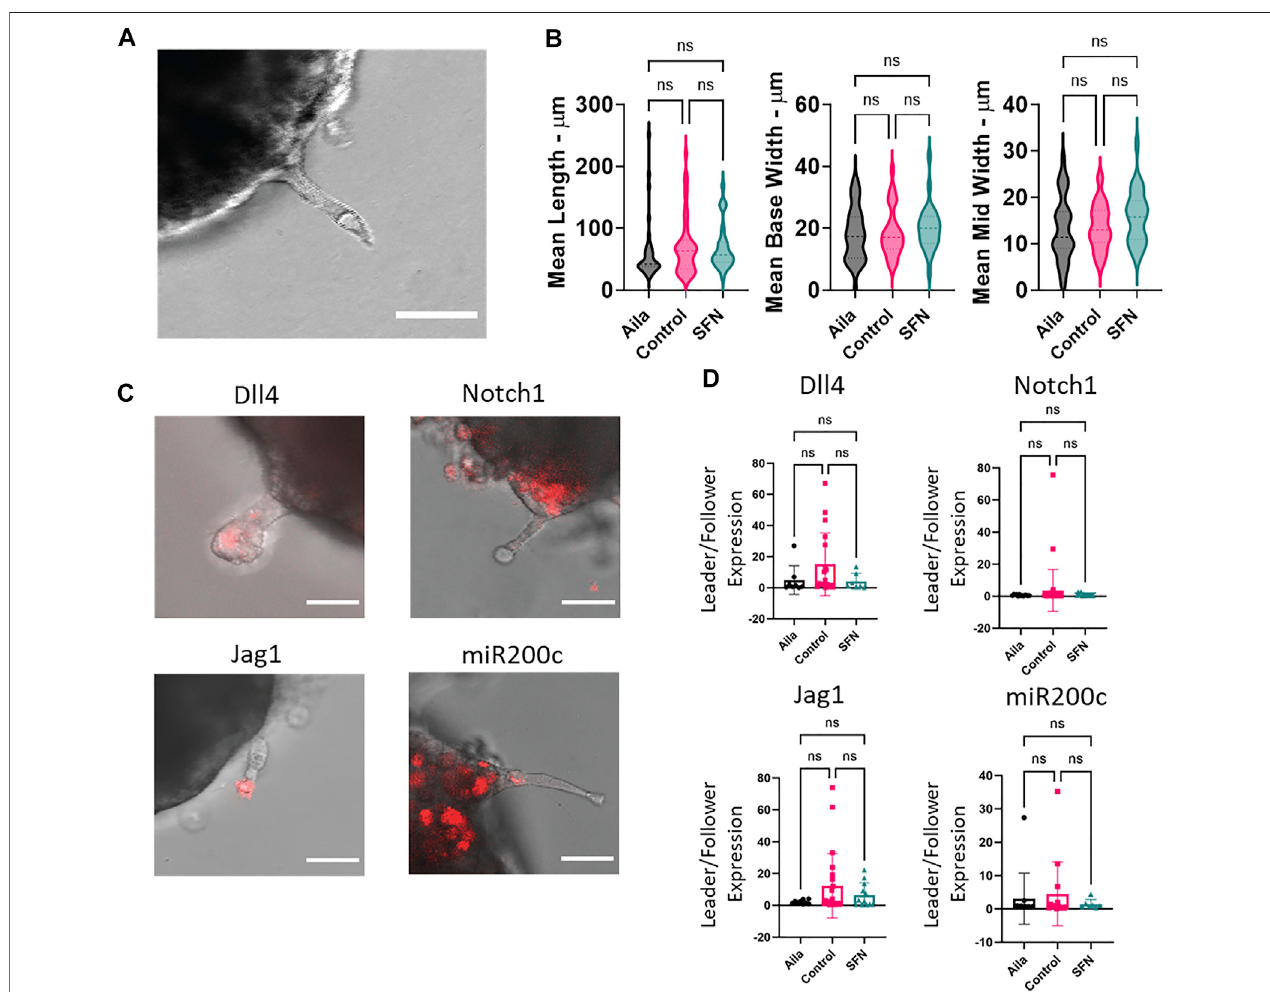
FIGURE9| Theeffects ofAilanthoneand sulforaphaneonleader and follower cells. (A) Representativeimage ofasproutprotrudingfrom a3Dmicrotumor formed byHeLacells. (B) Unlikethenumberofsprouts,themorphology(e.g.,widthandlength)ofthesproutswasnotsigni fi cantlyaffectedbyAliaandSFNtreatment.One-way ANOVA with post-hoc Tukey ’ s test was used to compare across groups (Aila n = 29 branches, Control n = 49 branches, SNF = 27 branches). The experiment was performedthreetimesacrossdifferentdays. (C) OverlayimagesmeasuringmRNAlevelsofDll4,Notch1,Jagged1,andmiR-200cinleaderandfollowercells.Scale bars, 50 µm. (D) Relative expressionsof Dll4mRNA, Notch1 mRNA, Jagged1 mRNA, and miR-200c betweenleader and follower cells ininvadingsprouts. Leader cells in the control case generally expressed high Dll4 and Jag1 (mean values of leader/follower expression > 1) while follower cells expressed higher Notch1 and miR200c across cases (mean values of leader/follower expression < 1). The D ’ Agostino and Pearson test was used to determine data that are not normally distributed (Dll4: Alia p -value = 0.4740, Control p -value < 0.0001, SFN p -value = 0.2233. Notch1: Alia p -value = 0.2618, Control p -value < 0.0001, SFN p -value = 0.0259. Jag1: Alia p -value < 0.0001, Control p -value = 0.0169, SFN n is too small. mi200c: Alia p -value < 0.0001, Control p -value p -value < 0.0001, SFN n is too small). For Dll4, Notch1, Jag1, and miR200c respectively: Aila n = 9, 13, 8, 12 branches, Control n = 22, 37, 18, 14 branches, SNF = 12, 13, 7, seven branches. Results are from three experiments performed across different